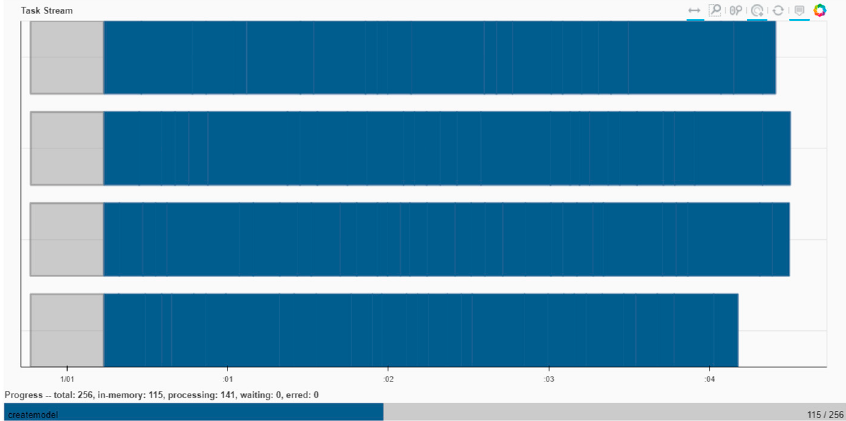
Figure 20. Dask profiling.